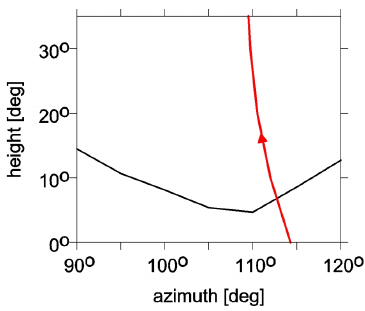
Figure 11: Terrain profile in direction west-south from pyramid. The red line shows the sunrise at summer